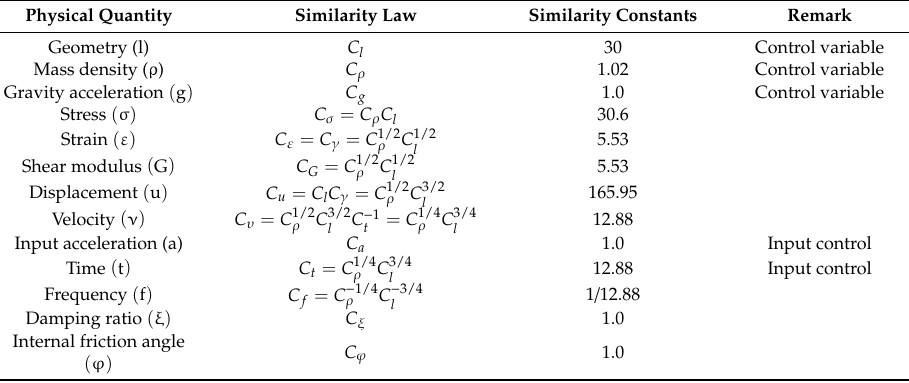
Table 1. Similar laws of aeolian sand high embankment slope